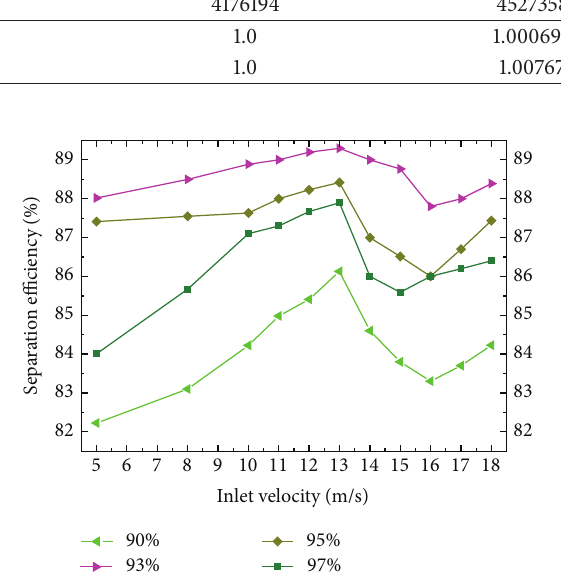
Figure 10: The influence of inlet velocity on separation